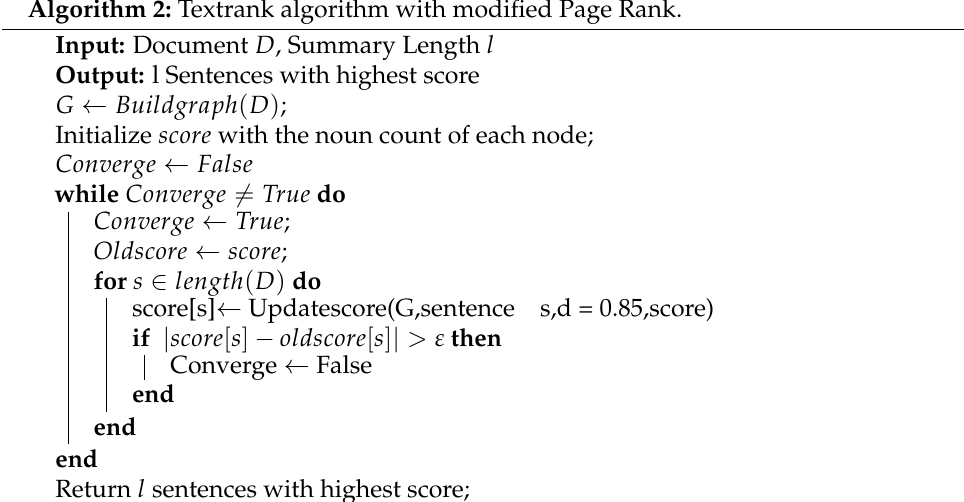
Algorithm 2: Textrank algorithm with modified Page Rank.